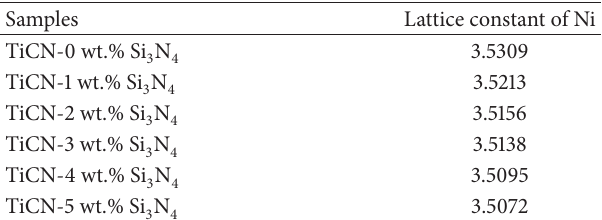
Table 2: Lattice constant of Ni in the as-prepared TiCN-based cermets.